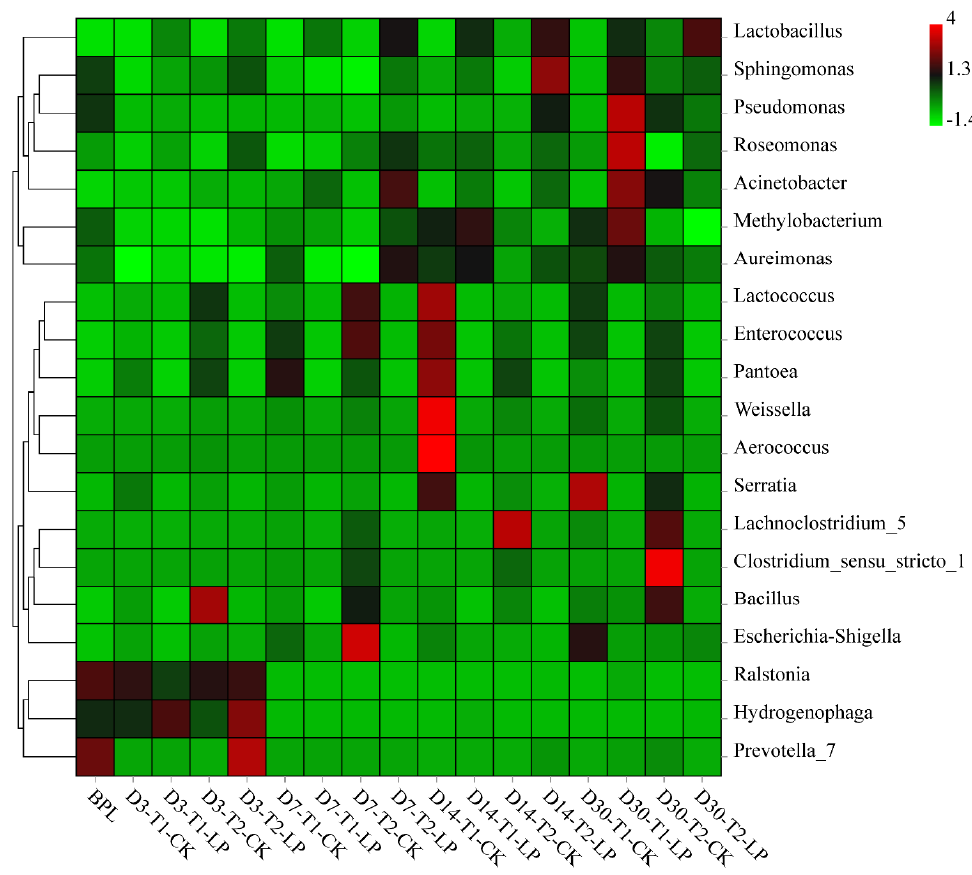
Figure 3. Heatmap of prominent bacterial genera (20 most abundant genera) for B. papyrifera leaves silage (days 3, 7, 14, 30) treated with LP inoculant and stored at 15 ◦ C (T1) and at 30 ◦ C (T2). BPL, B. papyrifera leaves; CK, the control; LP, Lactobacillus plantarum; D3, D7, D14, D30, after 3, 7, 14, 30 days ensiling, respectively.